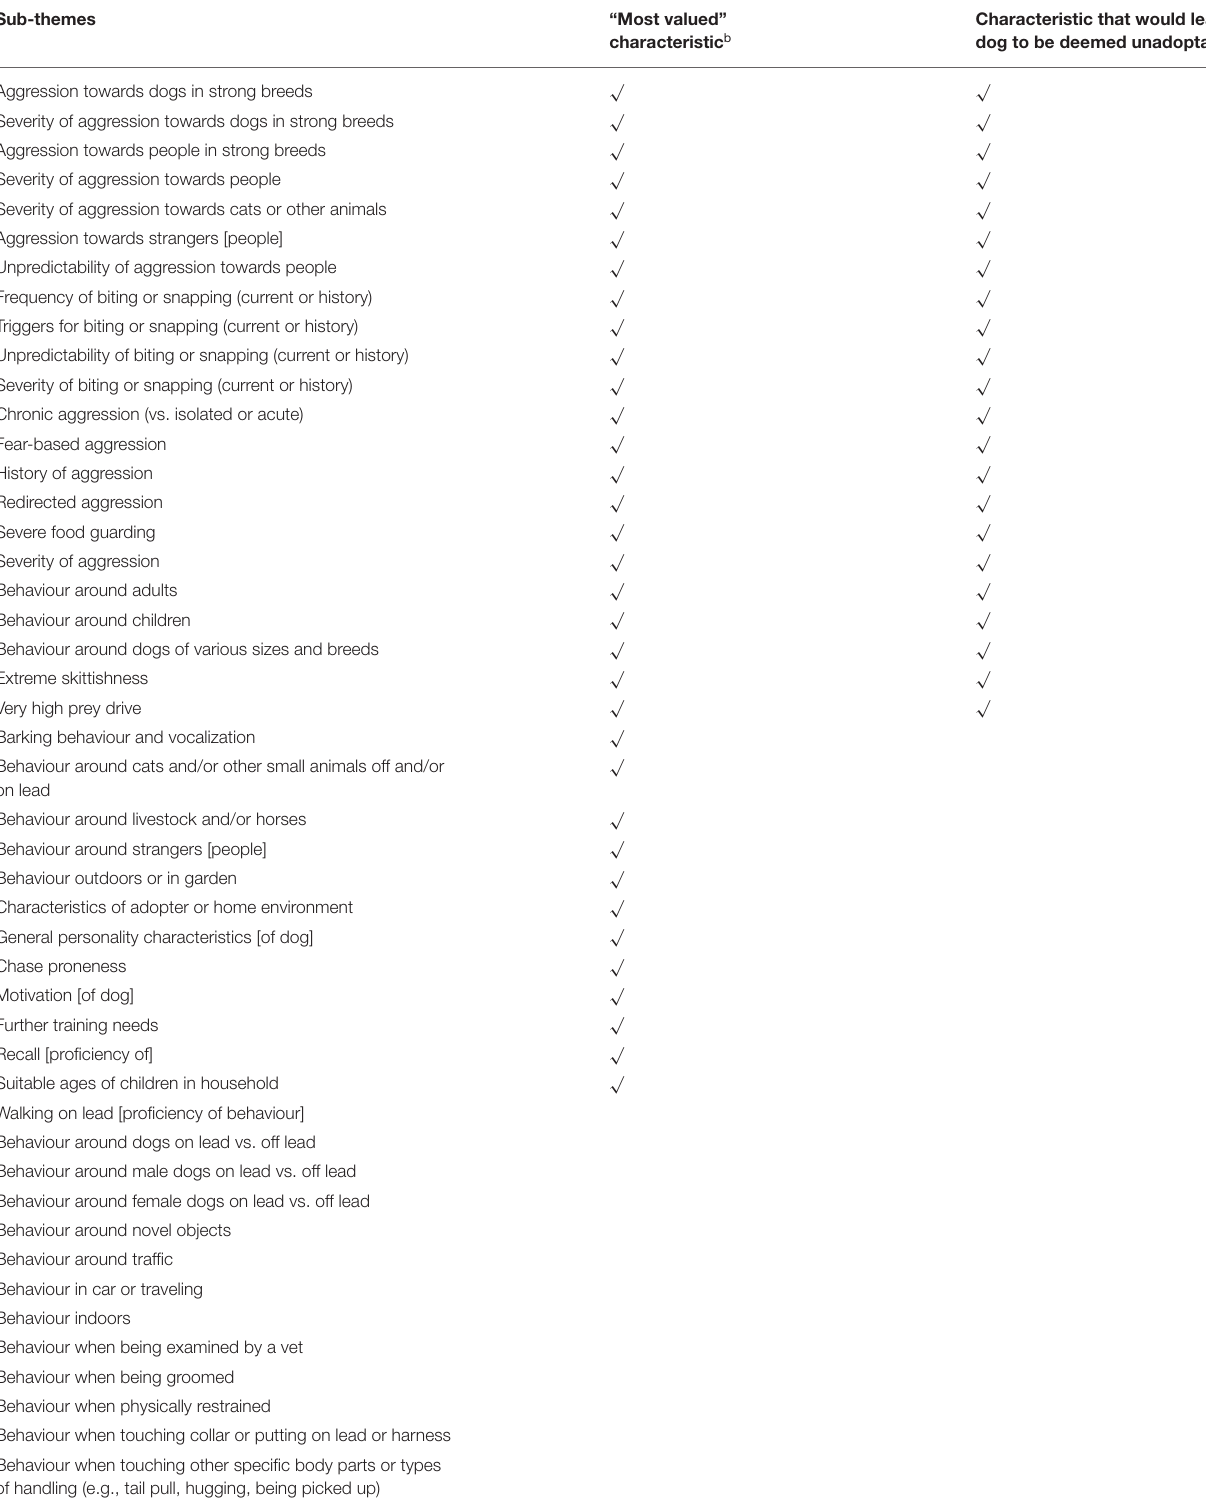
TABLE 6 | Dog assessment sub-themes (characteristics) for which there is no evidence a in the literature to support their inclusion in pre-adoption behaviour